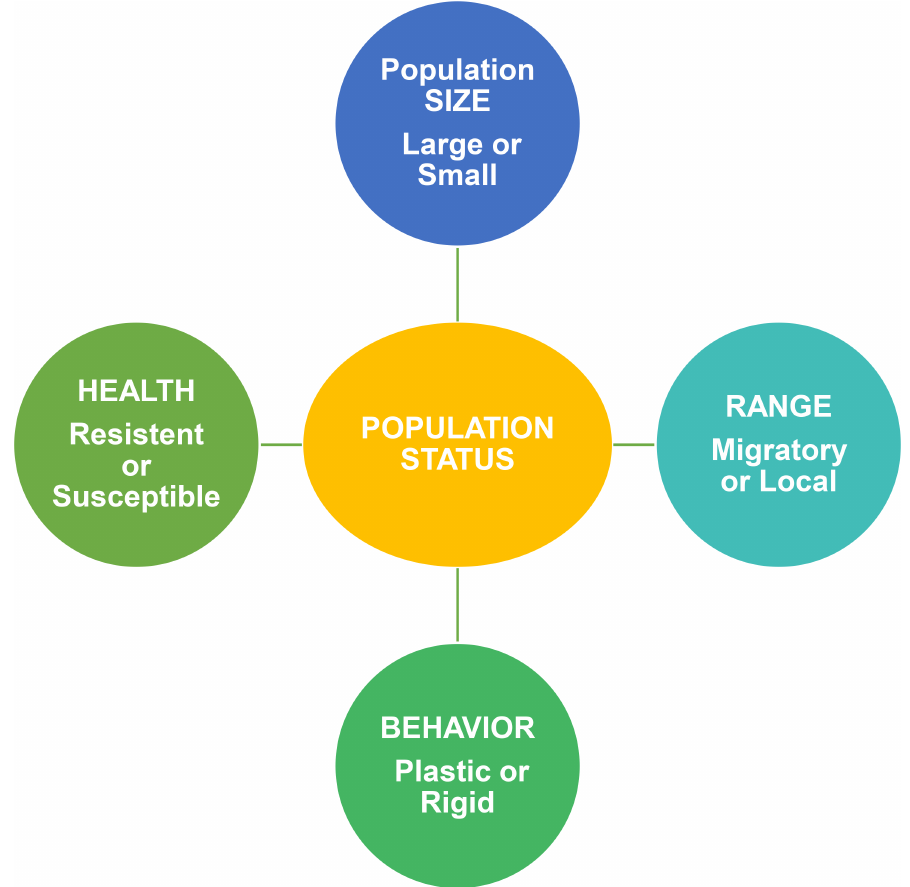
Fig 2. Contribution of 4 metrics to an assessment of a marine mammal population’s status; a simplified approach relevant everywhere but needed with special urgency to prioritize and expedite management and conservation actions in the context of ongoing rapid ecosystem alteration in the